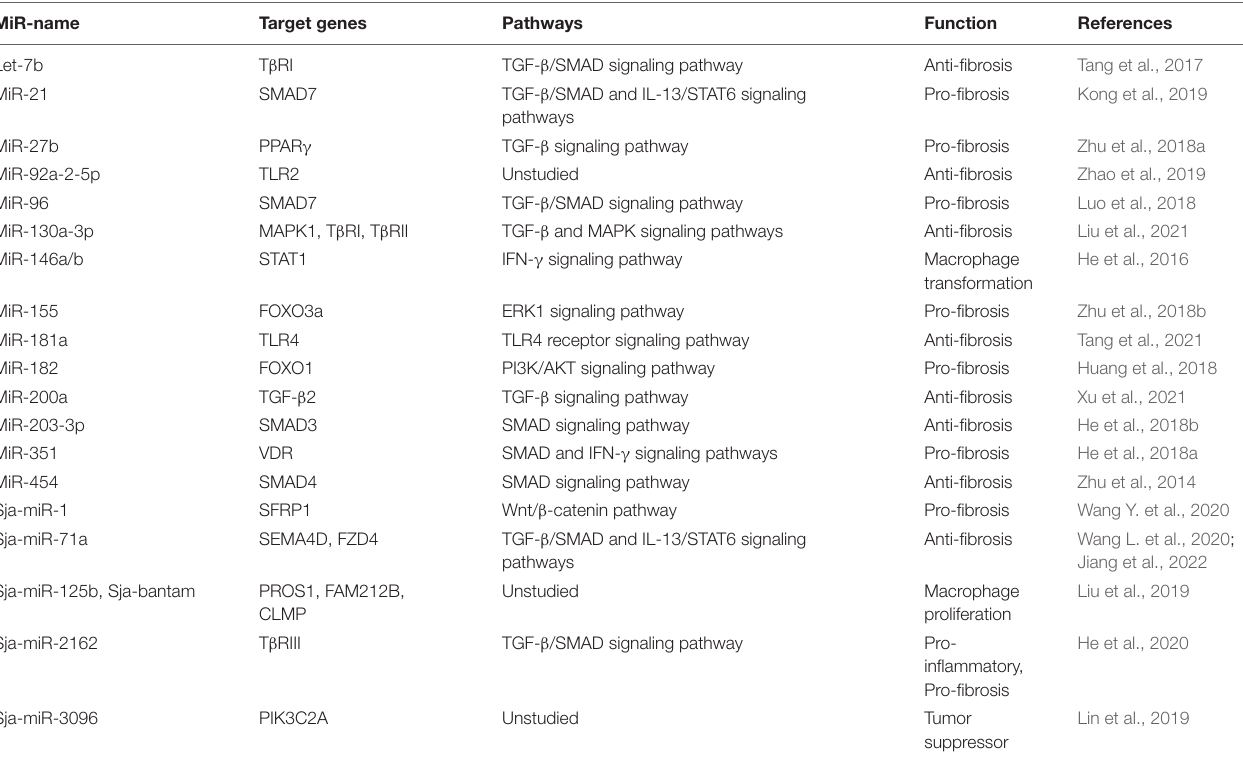
TABLE 2 | Summary of miRNAs involved in the pathogenesis of